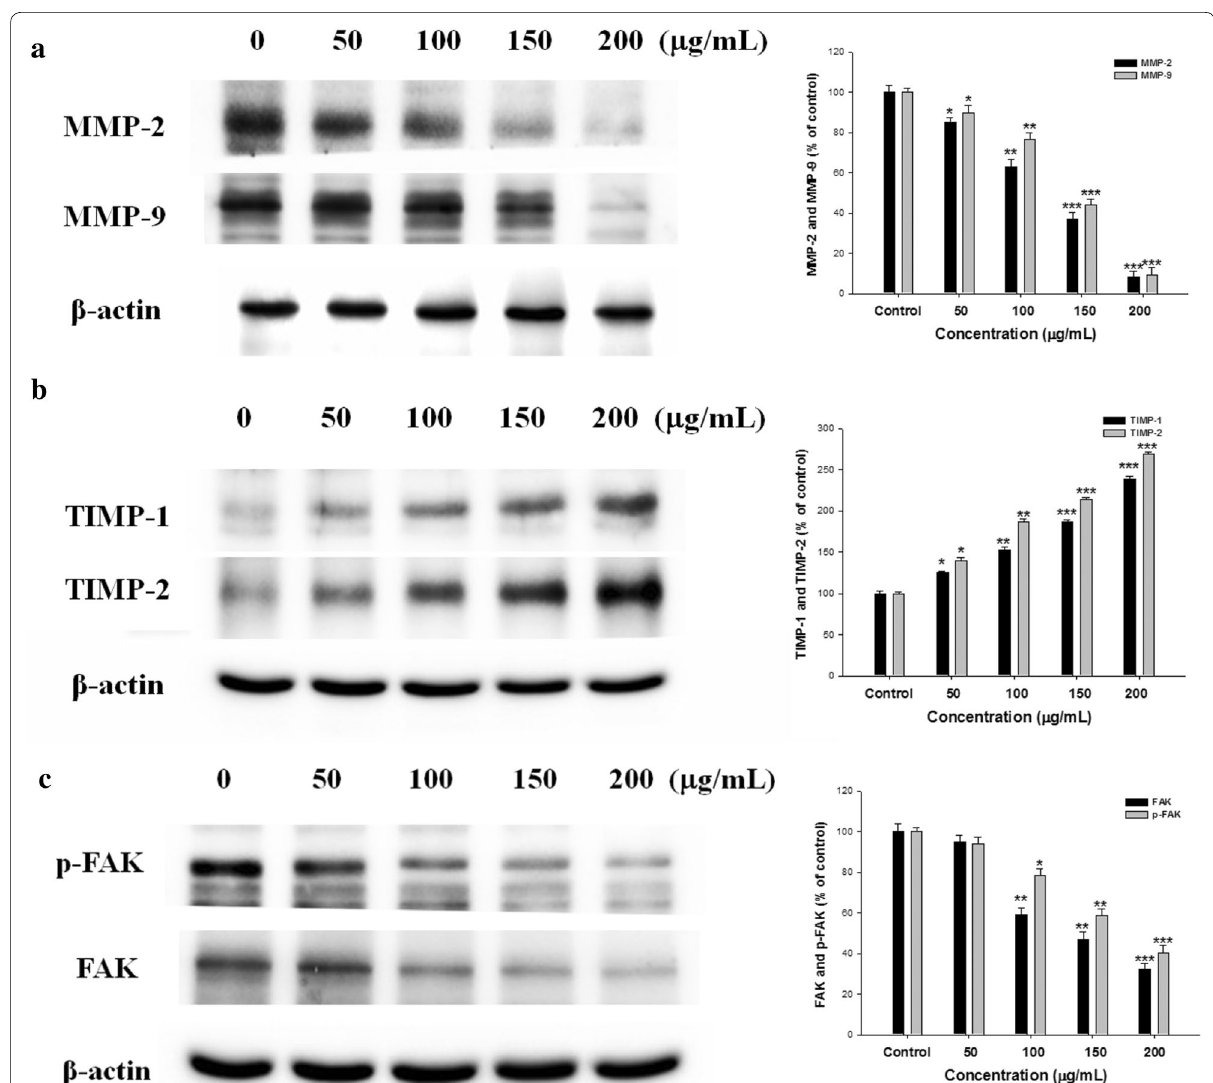
Fig. 4 Effects of EAAC on MMP ( a ), TIMP ( b ), and FAK ( c ) protein expressions. Analyzed by western blot, SK‑Hep1 cells were treated with 0, 50, 100, 150, and 200 μg/mL for 24 h and cell lysates were subjected to SDS‑PAGE followed by western blotting. Activities of these proteins were subse‑ quently quantified by densitometric analyses, with the control set to 100%. The data were presented as mean performed in triplicate. * p < 0.05, ** p < 0.01 and *** p < 0.001 0.001 were compared with untreated control